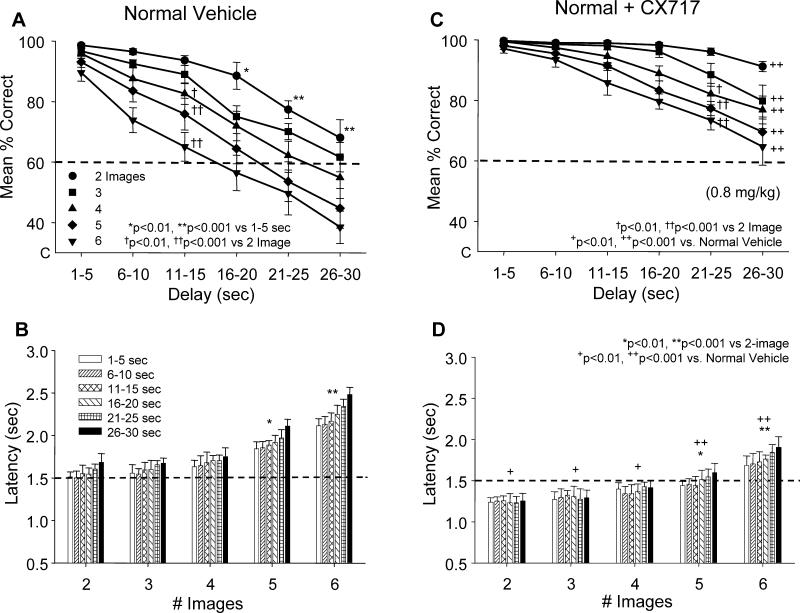
DMS Performance and Match Response Latency under Normal Vehicle and Normal + CX717 Conditions(A) Normal vehicle condition, mean (± SEM) percent correct DMS performance across 11 monkeys. Each curve reflects percent correct DMS trials sorted by number of images (two to six) in the match phase on trials with different delays (1–30 s plotted in 5-s increments). Performance decreased both as a function of delay and number of images as indicated by separation of curves across delays. “C” on y-axis indicates random or “chance” performance level in task. Asterisks indicate degree of separation from 1–5 s delay trials for significant (*p < 0.01, **p < 0.001) differences, and daggers indicate minimum degree of separation for significance (†p < 0.01, ††p < 0.001) compared to two-image trials.(B) Match phase response latencies in s (mean ± SEM) for trials shown in (A). Latencies on correct trials were sorted and plotted by number of images at specified delays. Asterisks indicate significant differences (*p < 0.01, **p < 0.001) compared to the mean of two-image trials summed across all delays (dashed line).(C) Normal + CX717 condition; mean (± SEM) percent correct performance by the same animals as in (A) following administration of CX717 (0.8 mg/kg, IV) prior to start of session. Legend is the same as in (A) for number of images and duration of delay. Performance across both parameters was maximally facilitated as indicated by comparison to dashed line arbitrarily drawn at 60%. Daggers indicate significant difference compared to two-image trials (†p < 0.01, ††p < 0.001). Plus signs indicate significant mean differences (+
p < 0.01, ++
p < 0.001) compared to the respective number of images in normal vehicle condition.(D) Match response latencies in s (mean ± SEM) for normal + CX717 condition sorted by delay and number of images as in (B). Dashed line provides a basis for comparison with minimum latency (1.5 s) in normal vehicle condition (B). Asterisks indicate significant differences (*p < 0.01, **p < 0.001) at all delays compared to two-image trials. Plus signs indicate significant differences (+
p < 0.01, ++
p < 0.001) compared to the same trial type in normal vehicle condition (B).DOI: 10.1371/journal.pbio.0030299g002